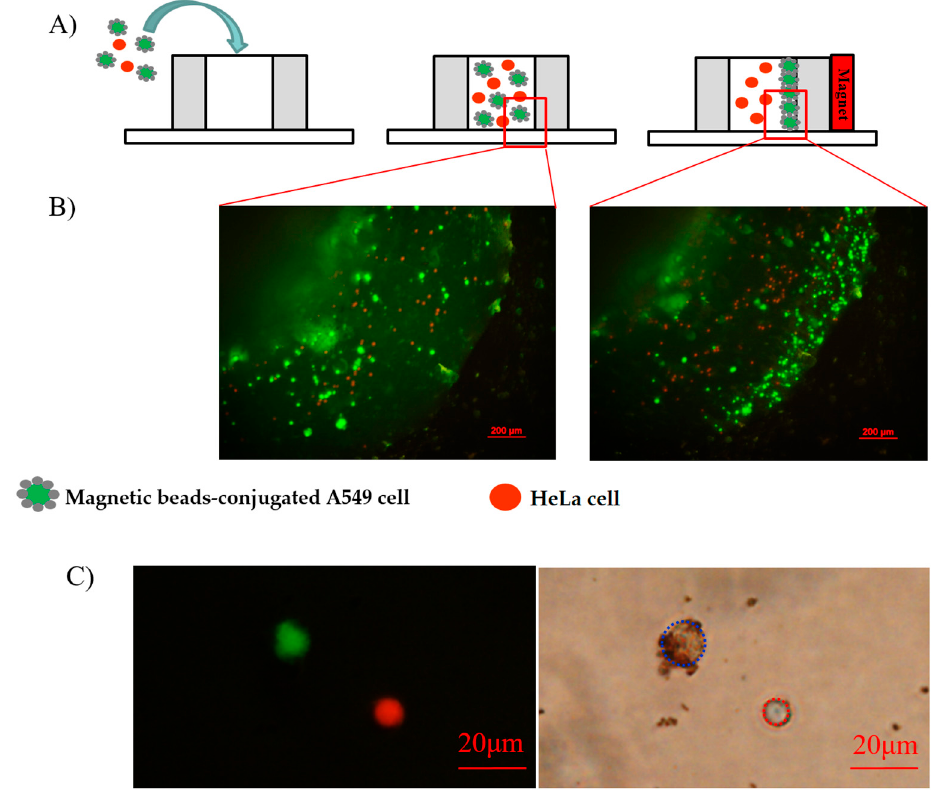
Figure 3. Characterization of the functionalized A549 cells. ( A ) Schematic illustration of the evaluation experiment for the combination of immunomagnetic beads and A549 cells. ( B ) Fluorescent images of the A549 cells and HeLa cells before and after applying a permanent magnet. ( C ) Fluorescence image and conventional image of the treated A549 cell and the stained HeLa cell.